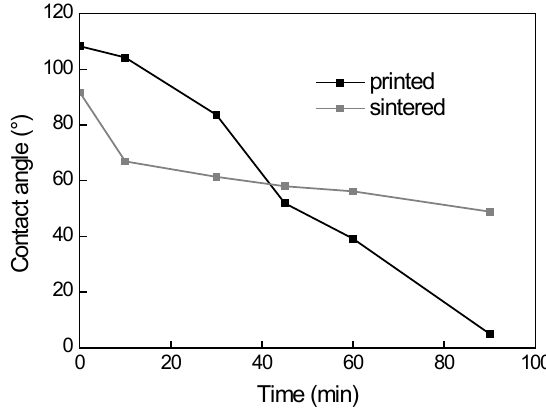
Figure 7. The dependence of relative contact angle on irradiation time for three layered samples. Printed “green body” layers ( top left ), thermally sintered layers ( top right ) and the comparison of absolute contact angle values for printed and sintered sample Ti_1 ( bottom